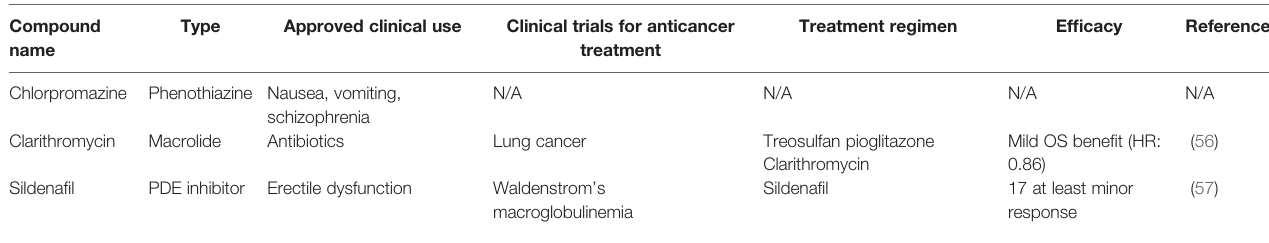
TABLE 3 | Summary of highlighted compounds that have been reported or investigated in combination with chemotherapy for anticancer